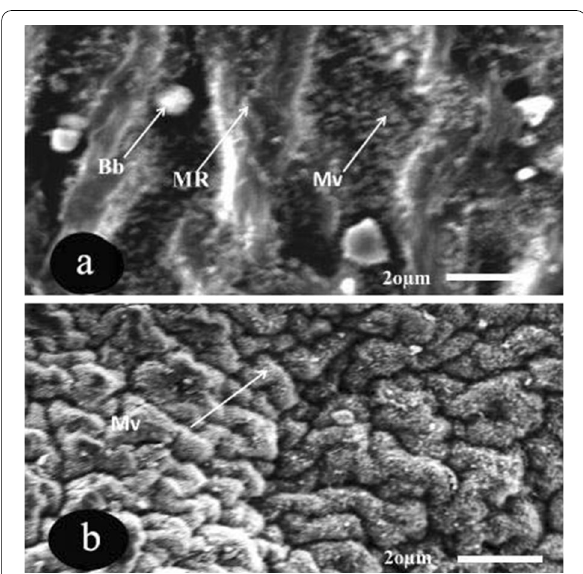
Fig. 6 SEM micrograph of the corneal epithelial cells of a Anas platyrhuncus, b Buteo buteo showing: Microridges (MR); Blebs (Bb) and Microvilli (Mv) (Scale bar, 20